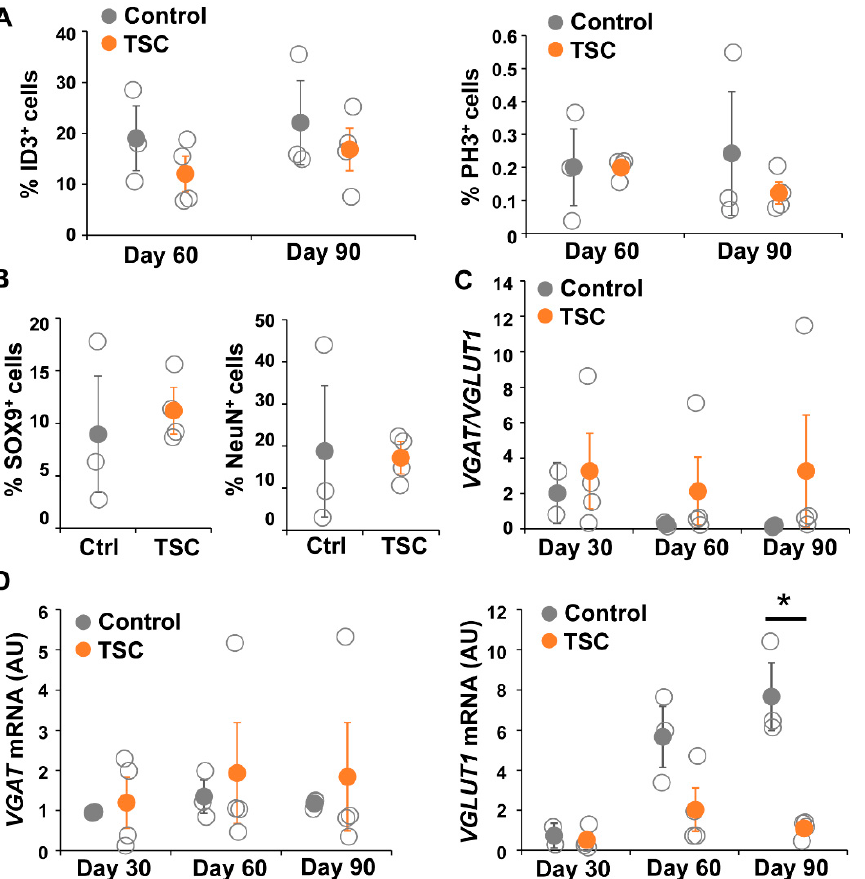
Figure 7. TSC organoids show altered synaptic balance. ( A ) Cell counts of the amount of ID3 + cells and PH3 + cells showed no differences between TSC and control organoids in the number of astrocytes (ID3) or proliferating cells (PH3). ( B ) Similarly, the percentage of SOX9 + and NeuN + cells was not changed between TSC and control organoids at day 90. ( C , D ) shows quantitative mRNA analysis for VGAT and VGLUT1 in day 30, day 60 and day 90 TSC and control organoids. VGLUT1 mRNA is significantly decreased in day 90 TSC organoids compared to controls, leading to an (not-significantly) altered ratio of VGAT/VGLUT1 . Data points represent data for each iPSC line (average of three or four organoids) with solid data points representing the mean per condition ± SEM. * = p < 0.05. Statistical test: independent samples t-test. NC = negative control, AU = arbitrary units.